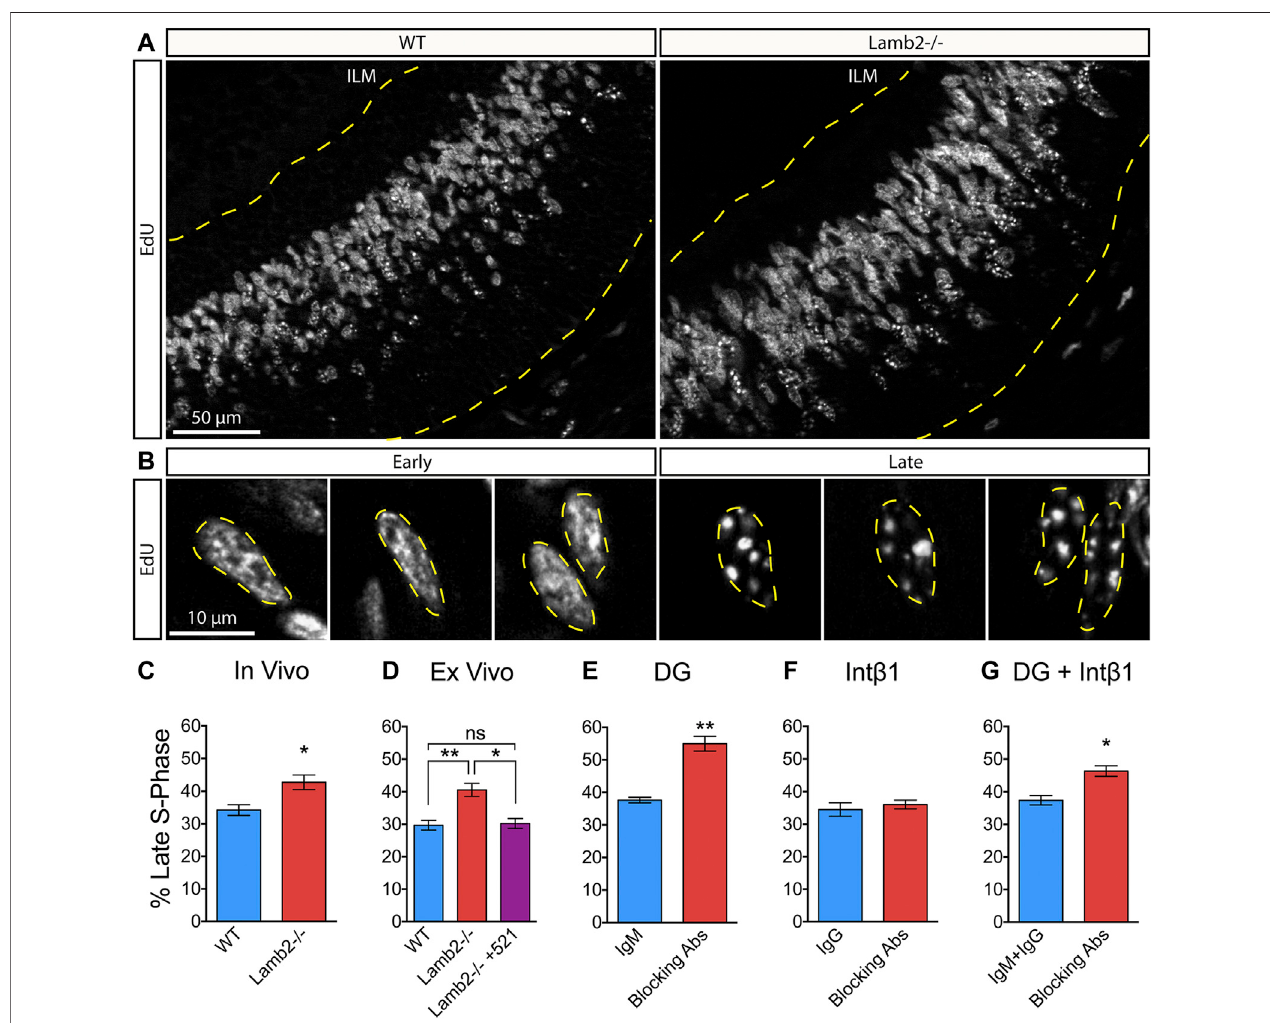
FIGURE 4 | β 2-containing laminins regulate RPC S-phase progression via DG. (A) . EdU labeling in P3 retinal cross-sections. Dashed lines delineate the retinal tissuelimits. ILM — inner limiting membrane. (B) . Highpower representative images ofRPCs in early (left)and late (right) S-phases. Repliconactivity isre fl ected inpattern of EdU incorporation. Early S-phase is characterized by high number of active replicons, leading to a uniform EdU incorporation. Late S-phase is characterized by low numberofactivereplicons,leadingtopunctateEdUincorporation. (C) .Quanti fi cationofRPCsinlateS-phaserelativetoRPCsinallstagesofS-phaseinP3WTand Lamb2 − / − cross-sections.Lamb2 − / − RPCsdisplayhigherpercentageofcellsinlateS-phaserelativetoWT. (D) .Quanti fi cationofRPCsinlateS-phaseinretinalexplants. Lamb2 − / − explants display higher percentage of late S-phase cells, compared to WT. Addition of laminin 521 rescues this effect, restoring normal early/late S-phase ratios. (E) . Quanti fi cation of RPCs in late S-phase in WT retinal explants with and without α -DG blocking antibodies. Blocking α -DG signaling results in increased percentage of late S-phase RPCs. (F) . Quanti fi cation of RPCs in late S-phase in WT retinal explants with and without int β 1 blocking antibodies. Blocking int β 1 signaling has no effect on percentage of late S-phase RPCs. (G) . Quanti fi cation of RPCs in late S-phase in WT retinal explants with and without a combination of α -DG and int β 1 blocking antibodies. Blocking both signaling pathways results in increased percentage of late S-phase RPCs. Each data point represents the average of technical and biological experimental replicates ± SEM. Statistical analysis was performed using Student ’ s t-test. * — p ≤ 0.05. ** — p ≤ 0.01. NS — not signi fi cant.